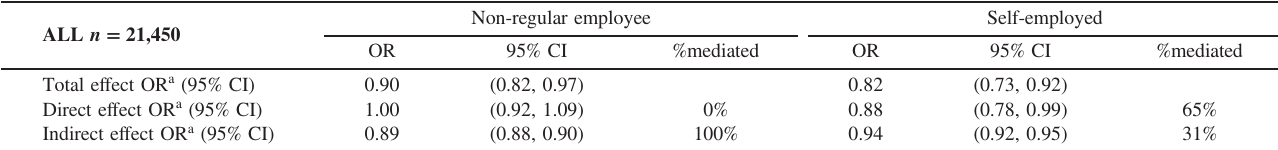
Table 3. Mediation analysis between employment type and poor self-rated health through work-family con fl ict among Japanese